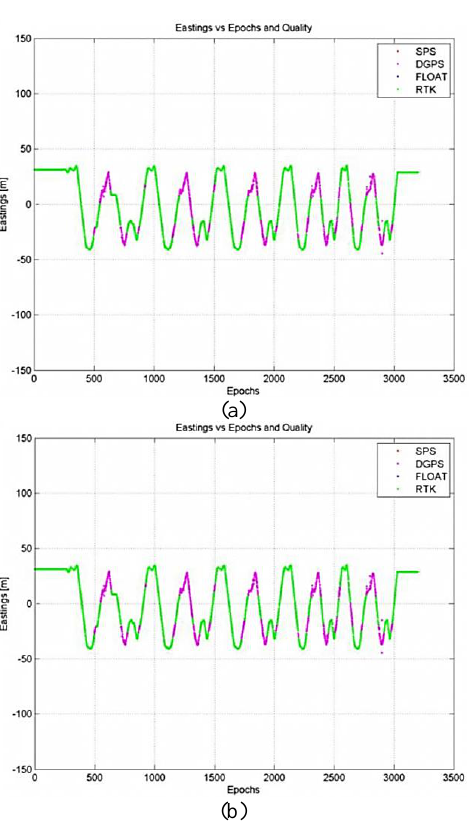
Figure 4. GS10 Mobile Kinematic Results: (a) Easting Time Series; (b) Northing Time Series.